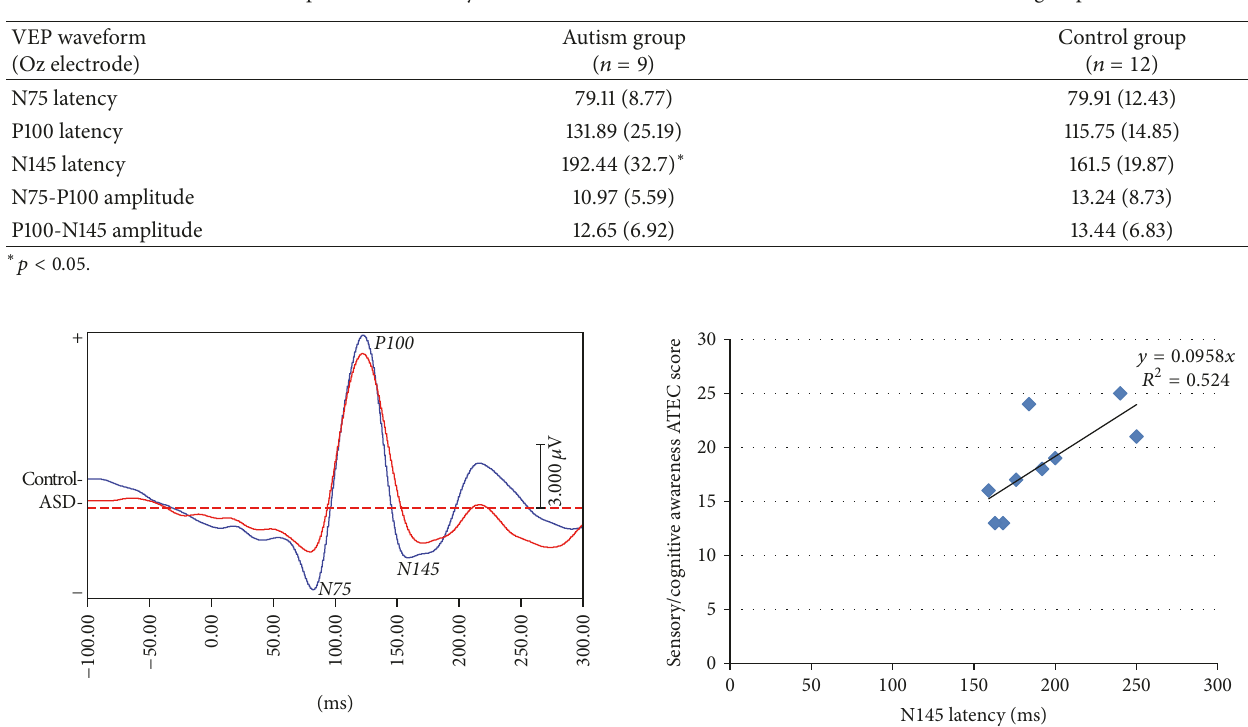
Table 2: The amplitude and latency of the VEP waveforms over the Oz electrode between the two groups.